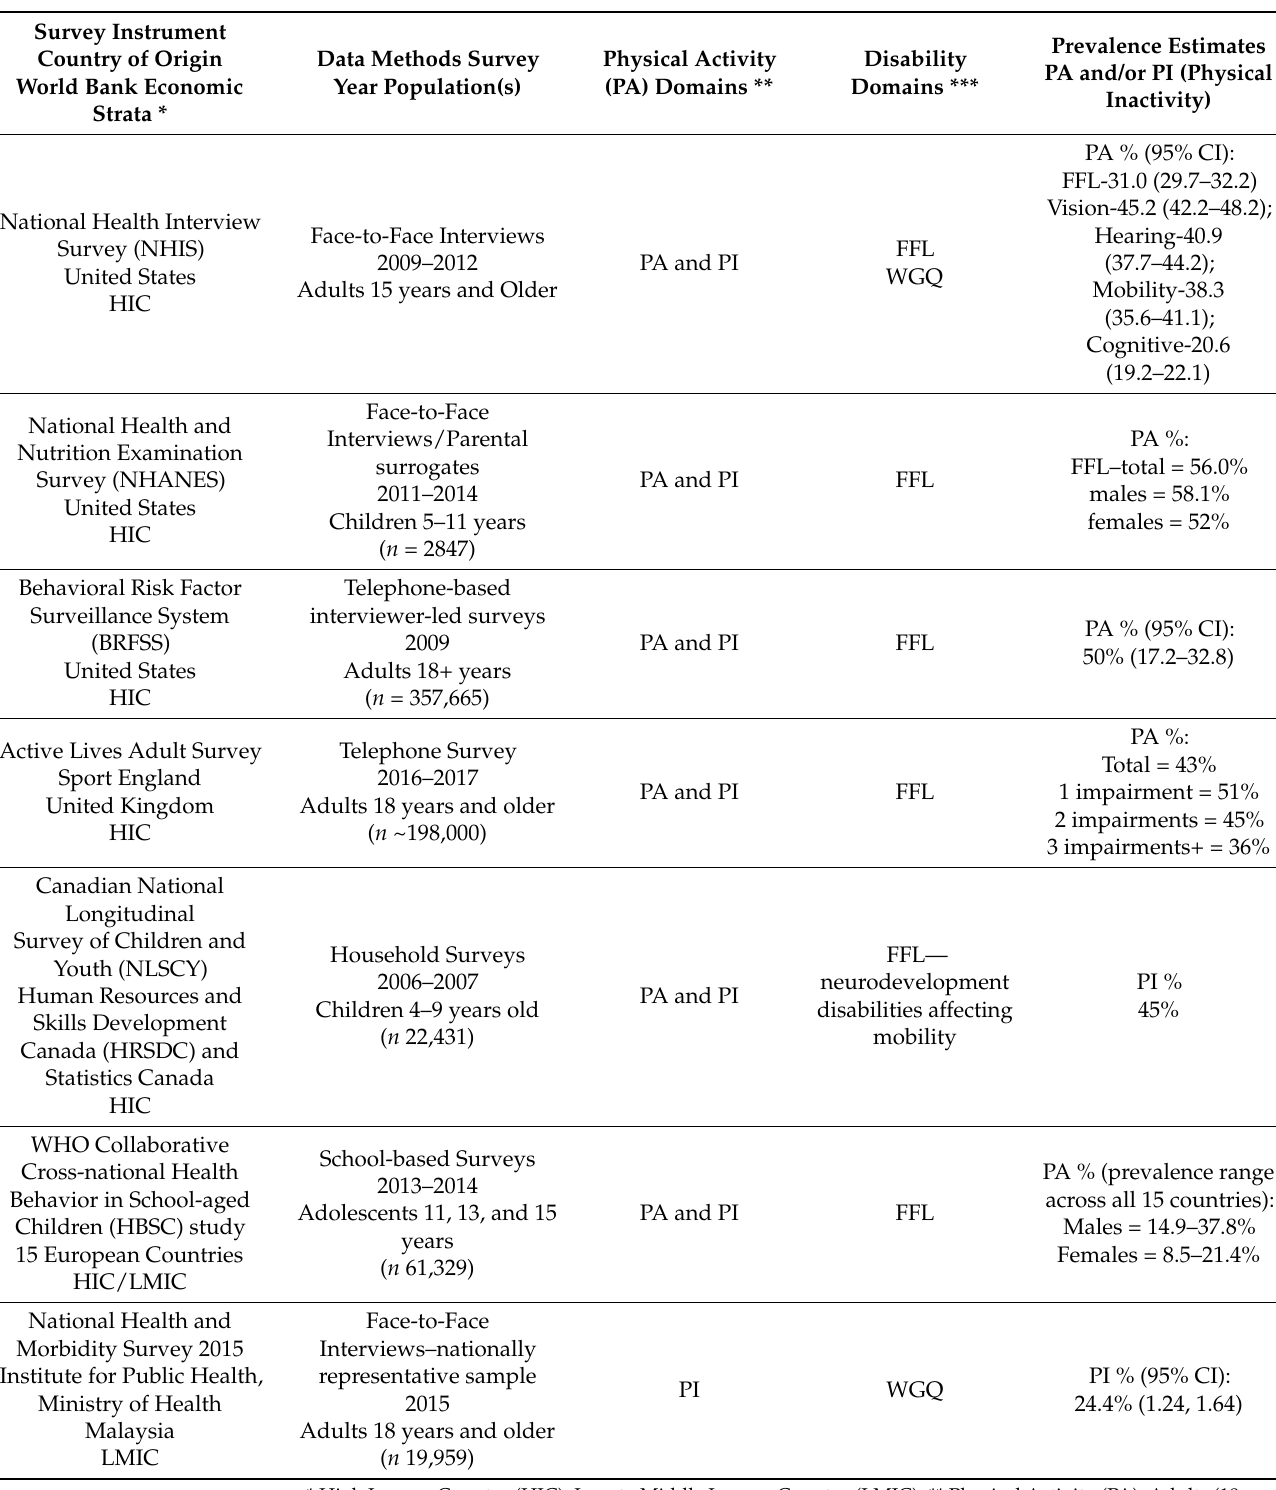
Table 2. Prevalence Estimates of Physical Activity among people with disabilities from around the globe: children; adolescents; adults; and older